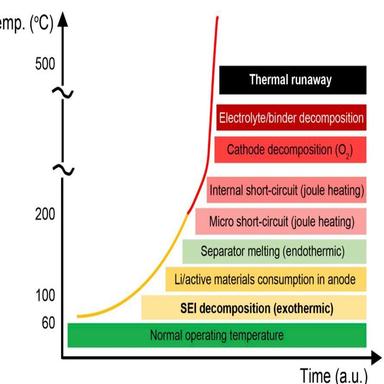
Schematic diagram of a typical thermal runaway process for Li-ion batteries as a function of temperature. The exothermic decomposition of the SEI typically starts at 60–120 �C, followed by reaction consumption of Li and active materials in the anode, separator melting, internal short-circuiting accompanying significant amounts of Joule heating, and finally leading to thermal runaway. Adapted with permission from Ref.. Copyright 2014 Elsevier.